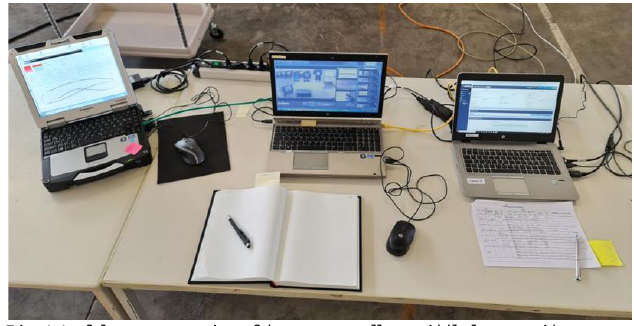
Fig. 4. Left laptop: operation of the source trolley, middle laptop: video system and right laptop: software of the device to be tested. The left laptop is for operating the source trolley, the middle one for the video system, and if needed we use another one for the test system. For example, for portal monitors the results are displayed on this third laptop and included via HDMI in the video system.